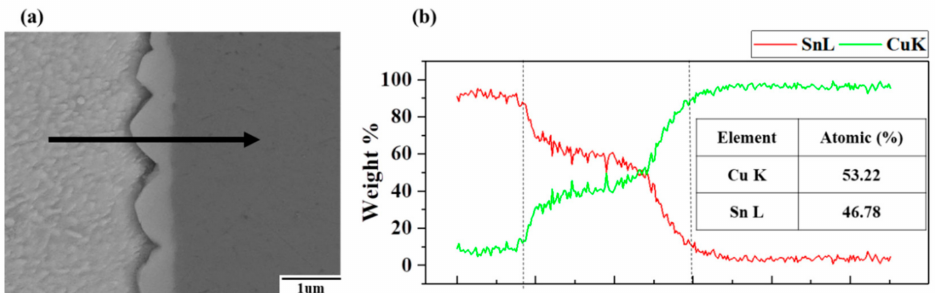
Figure 4. Cross-sectional images and corresponding EDS line scanning results of the intermetal- lic compounds (IMCs) for 3 s of dipping at 300 ◦ C at Sn-0.7Cu-0.2Cr/Cu: ( a ) SEM image and ( b ) EDS